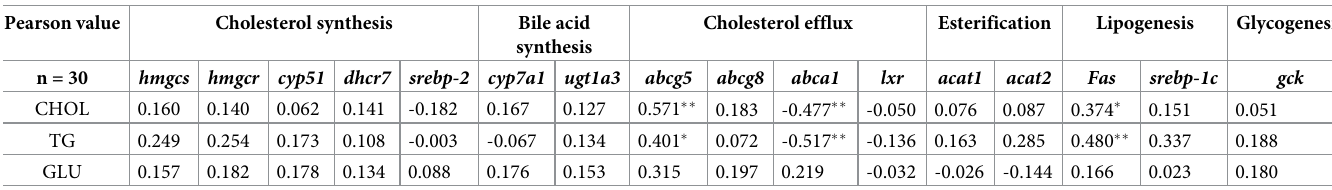
Table 4. Correlations between hepatic gene expressions involved in cholesterol metabolism and plasma parameters of rainbow trout. Pearson value Cholesterol